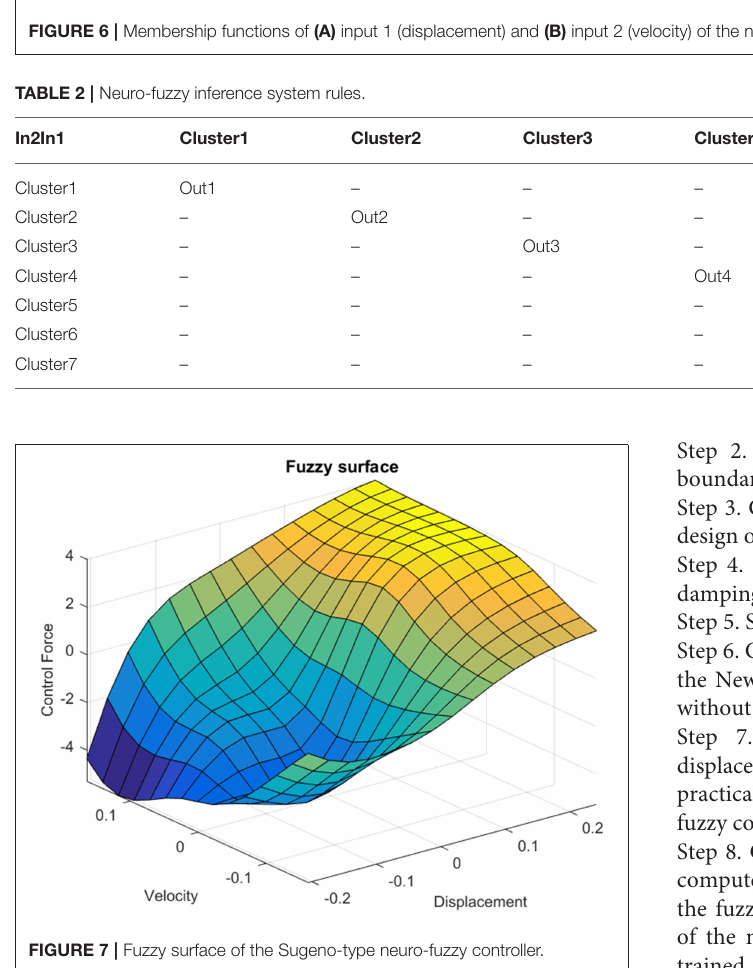
presented. Namely, the dynamic behavior of the mechanical finite element model is approximated by the numerical integration Newmark- β method. Then, with the use of the fuzzy and neuro-fuzzy logic dynamic control of the shape of the truss is performed. The steps of the algorithm are given